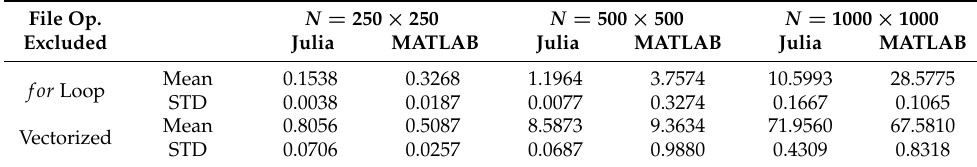
Table 4. Mean execution times and standard deviations of the heat equation solver written in MATLAB and Julia by excluding file operations. The mean execution times are given in second. Ten data points are used in the calculation of the mean and the standard